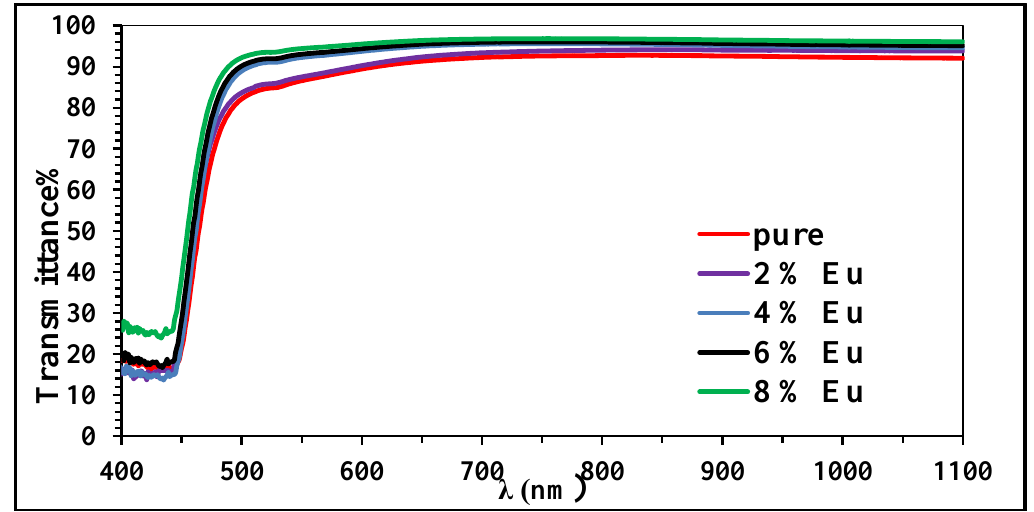
Fig.3: Transmittance as a function of wavelength for V 8)wt %. Eu